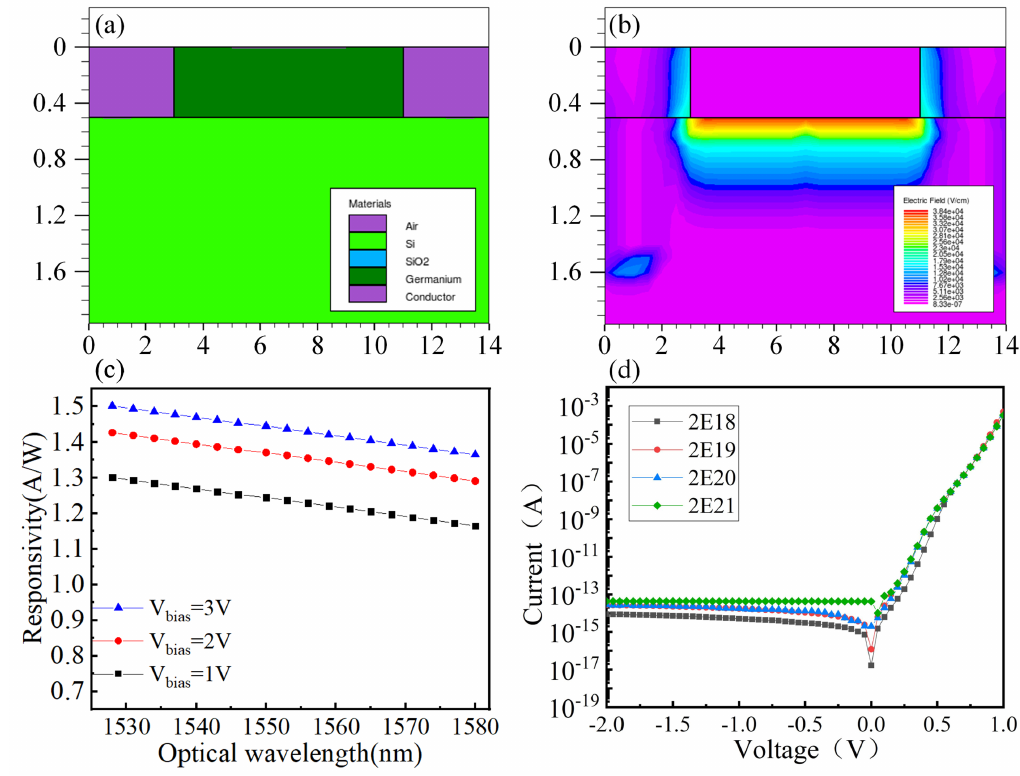
Figure 4. Structural performance and calculation of devices. ( a ) Structure simulation of the photodetector. ( b ) Electric field distribution of photoelectric detector. ( c ) Responsivity at different bias pressures. ( d ) Dark current at different doping